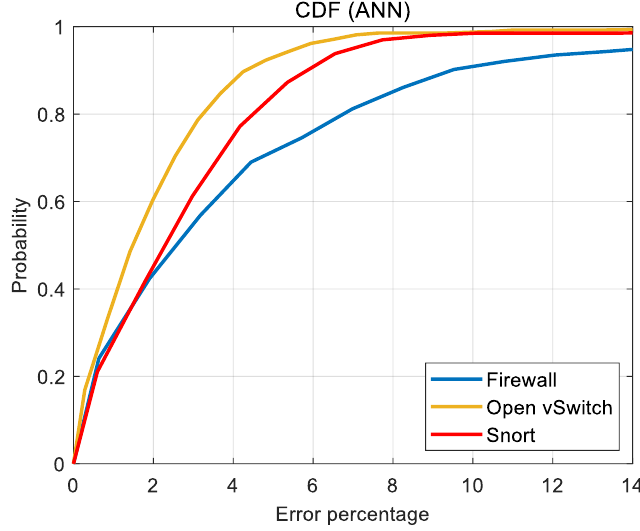
Figure 12. CDF of percentage prediction errors of FNN.